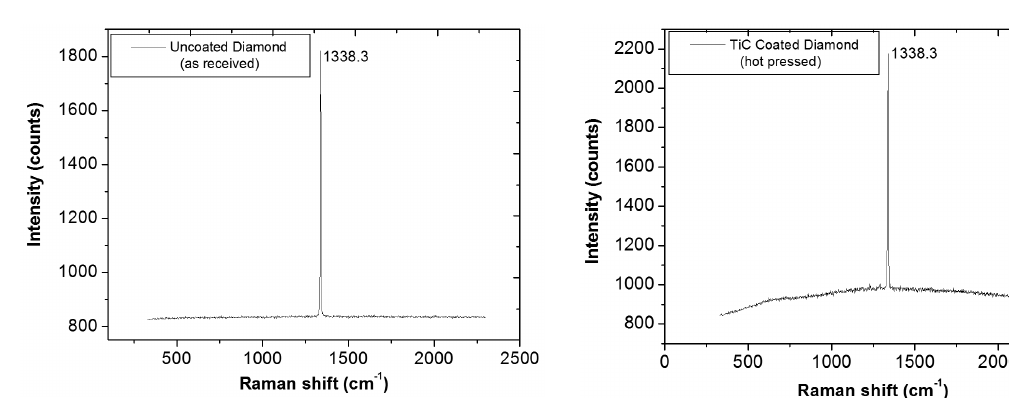
Figure 3. XRD pattern. TiC coated diamond crystals (hot pressed).